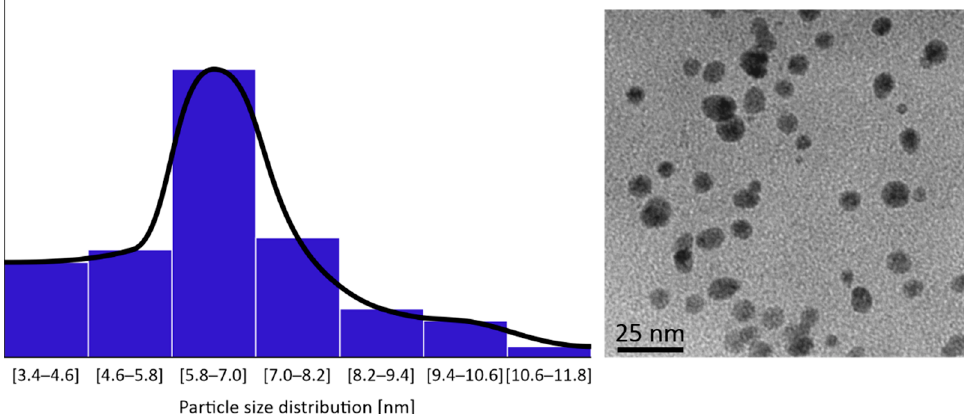
Figure 2. Indicative CuNPs shapes and size distributions as observed by HR-TEM on a JEOL JEM 2010 by Oxford INCA.